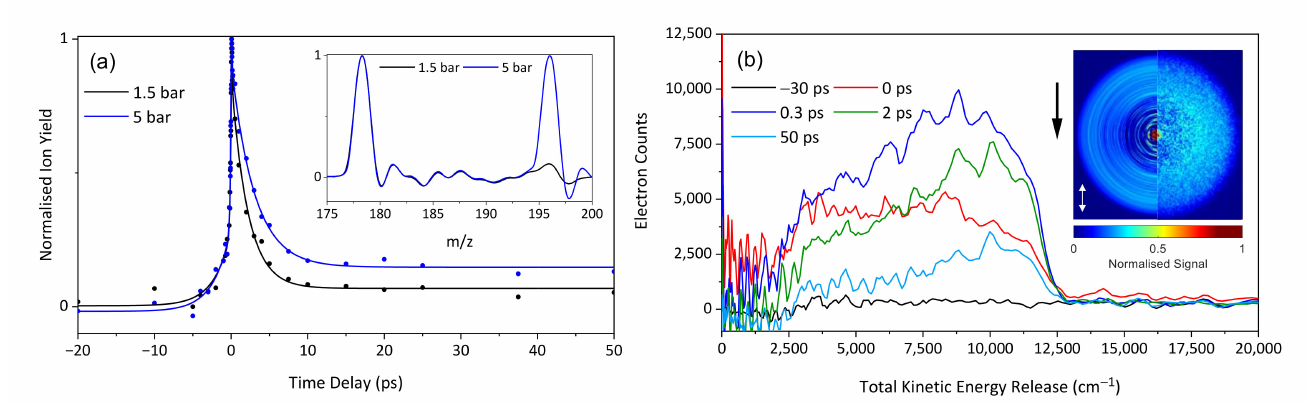
Figure 5. ( a ) TR-IY transient of p -HMC at 308.5 nm pump and 240 nm probe with a 1.5 and 5 bar helium backing pressure showing a larger baseline offset at 5 bar. Inset: time-of-flight mass spectrum, taken at 1.5 and 5 bar, showing the majority of ion-signal is p -HMC + (m/z = 178) at 1.5 bar and at 5 bar, ion-signal corresponding to [ p -HMC + H 2 O] + (m/z = 196) additionally appears. ( b ) TKER spectra of p -HMC obtained using the 308.5 nm pump and 240 nm probe with a 5 bar helium backing pressure. The following pump-probe time delays are used: ∆ t = − 30, 0, 0.3, 2 and 50 ps and an expected TKER max of 12,497 cm − 1 is indicated by the black arrow. Inset: right half presents the recorded image, while the left half presents the reconstructed slice through the centre of the original 3D ion distribution at ∆ t = 0.3 ps (the white arrow indicating the electric field polarisation of the laser pulses). For all data, the polarisations of the pump and probe beams were parallel with respect to each